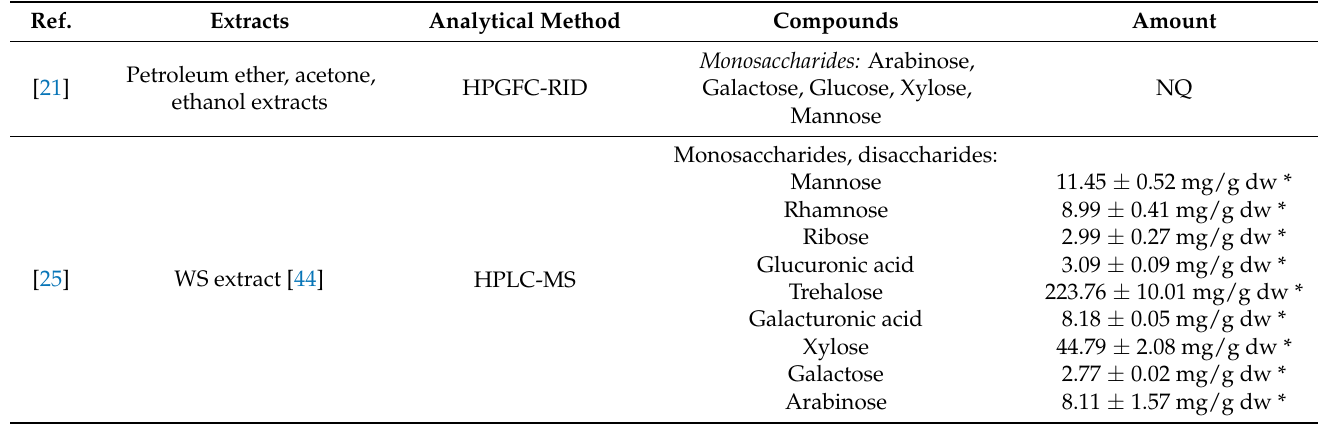
Table 4. Carbohydrate compounds identified and quantified in walnut septum.